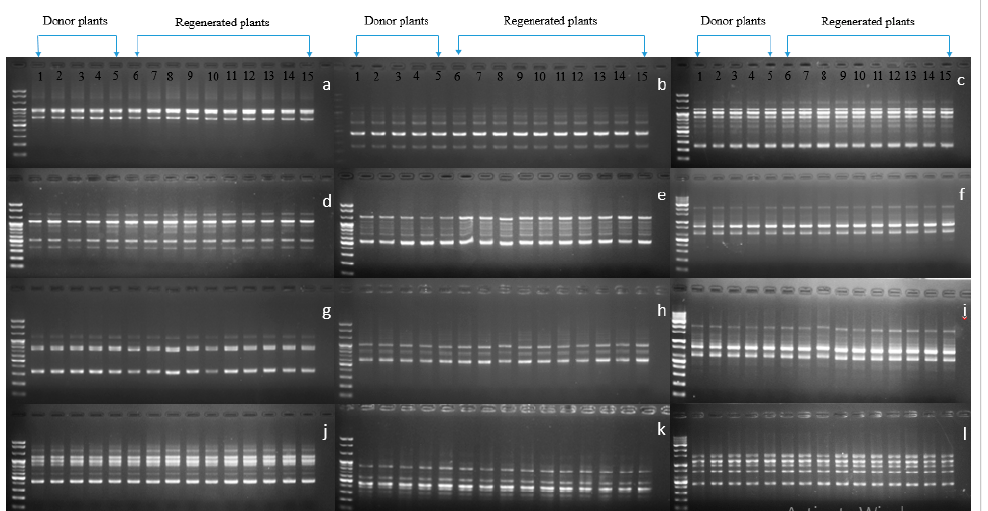
Figure 6. Showing genetic stability between vitrified-derived plants and donor plants using random amplified polymorphic DNA (RAPD) markers in cultivar Kumbuyl (KB). ( a ) OPA 03, ( b ) OPA 04, ( c ) OPA 07, ( d ) OPA 10, ( e ) OPA 19, ( f ) OPB 01, ( g ) OPB 17, ( h ) OPA 01, ( i ) OPA 02, ( k ) OPB 06, ( l ) OPB 07, ( m ) OPB 10.